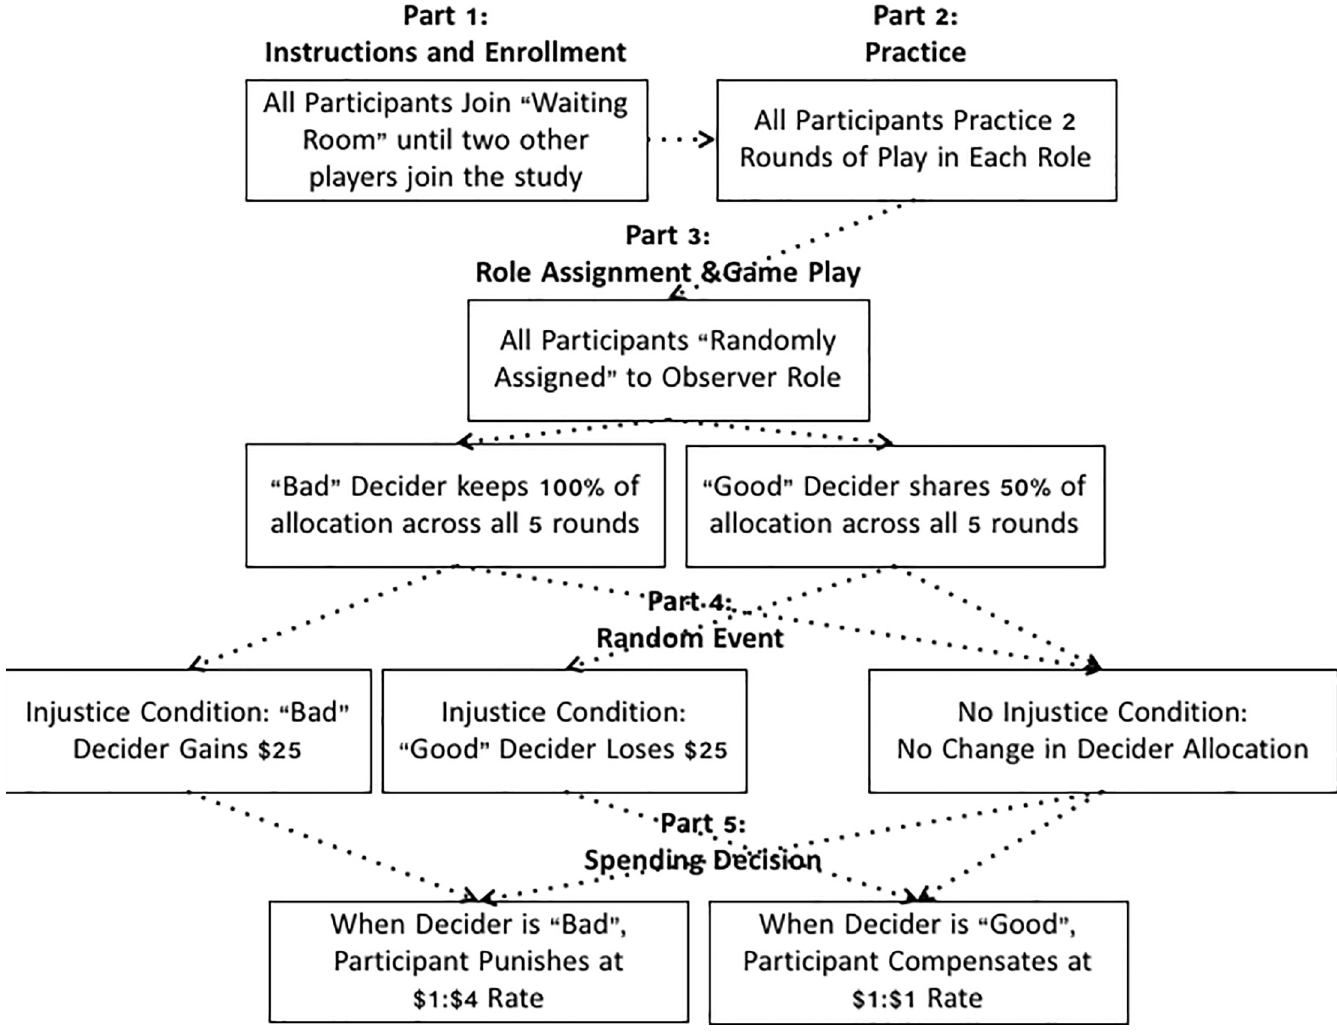
Fig 1. Summary of game